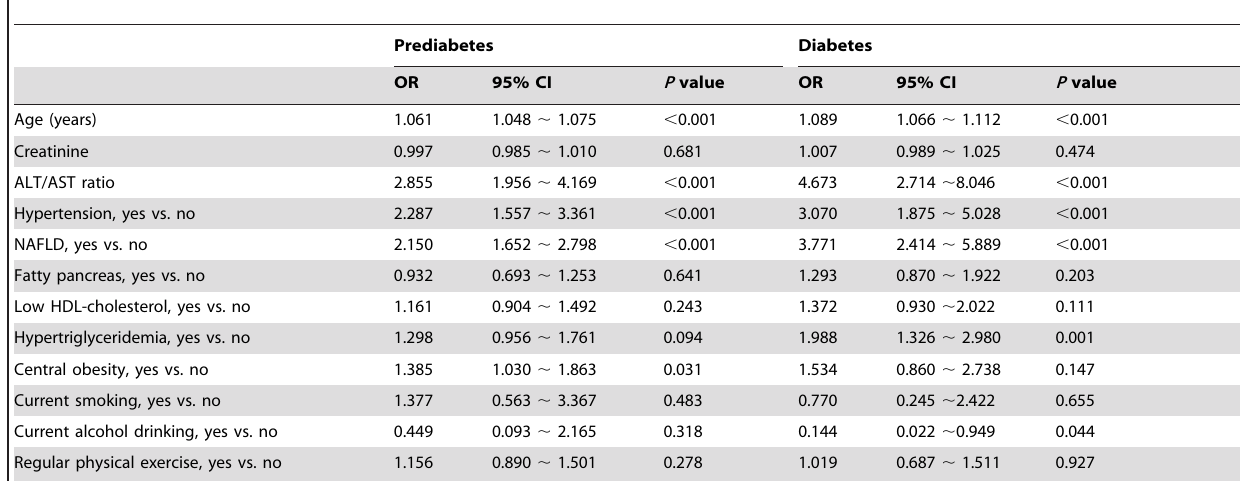
Table 3. Logistic regression analysis for factors associated with prediabetes and diabetes in female